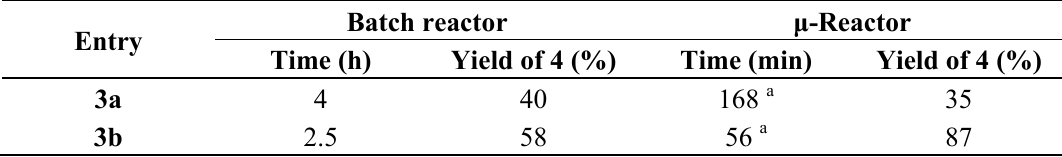
Table 1. Comparison of microreactor versus batch reactor